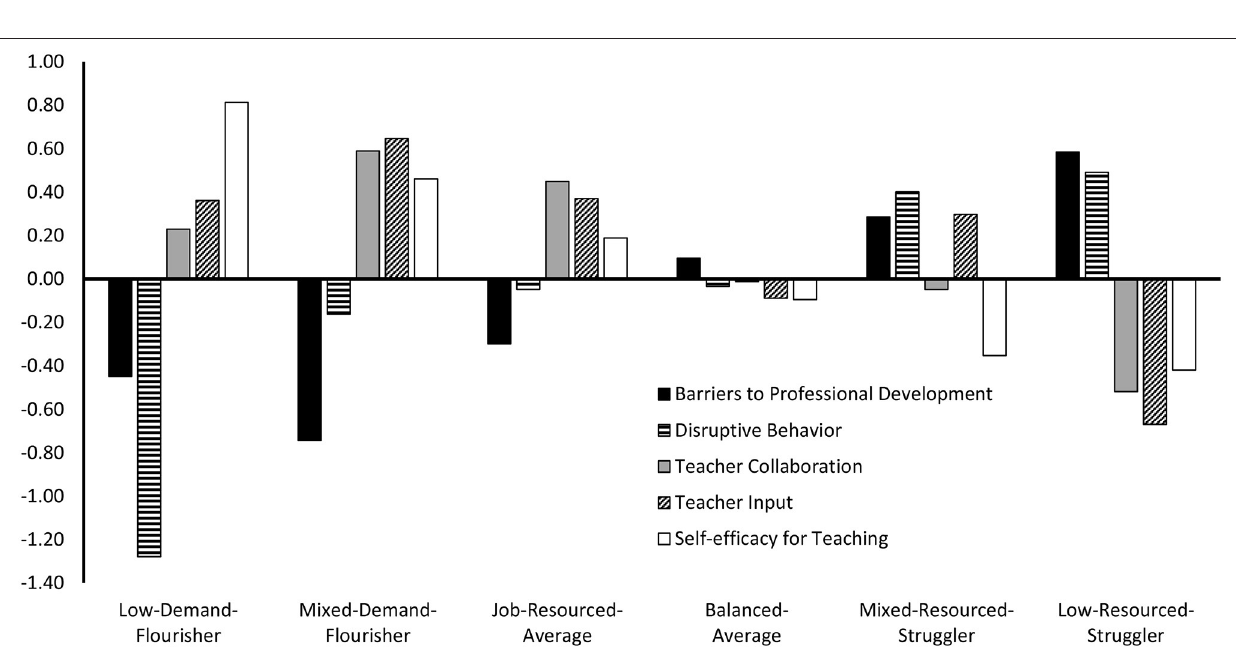
comparing matched profiles across the two countries, the two school profiles from the Australian sample displayed significantly higher levels on the two outcomes than the matching profiles estimated in the English sample. For the outcomes adjusted for school characteristics, the pattern of results was the same as that found for the unadjusted